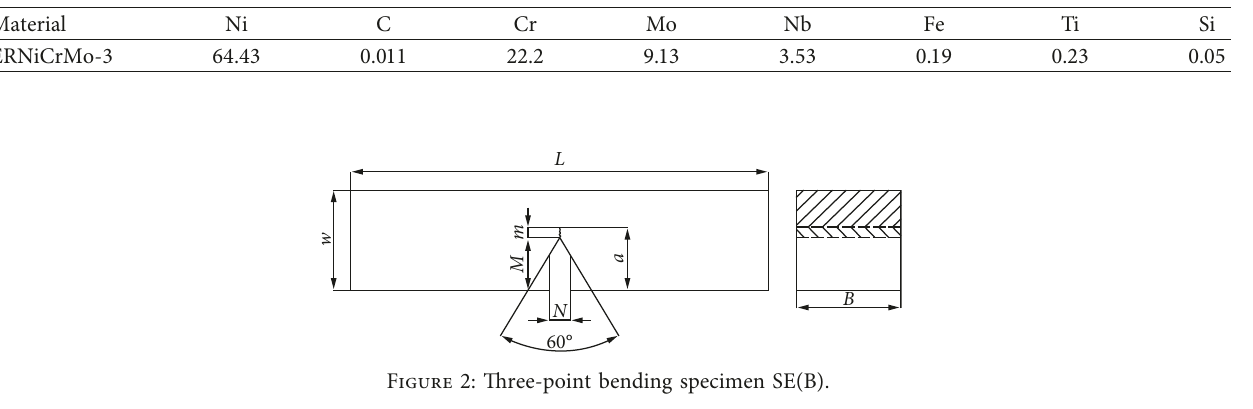
Figure 1: Bimetallic composite pipe welded joint. Table 2: Chemical composition of ERNiCrMo-3 (mass fraction/%).